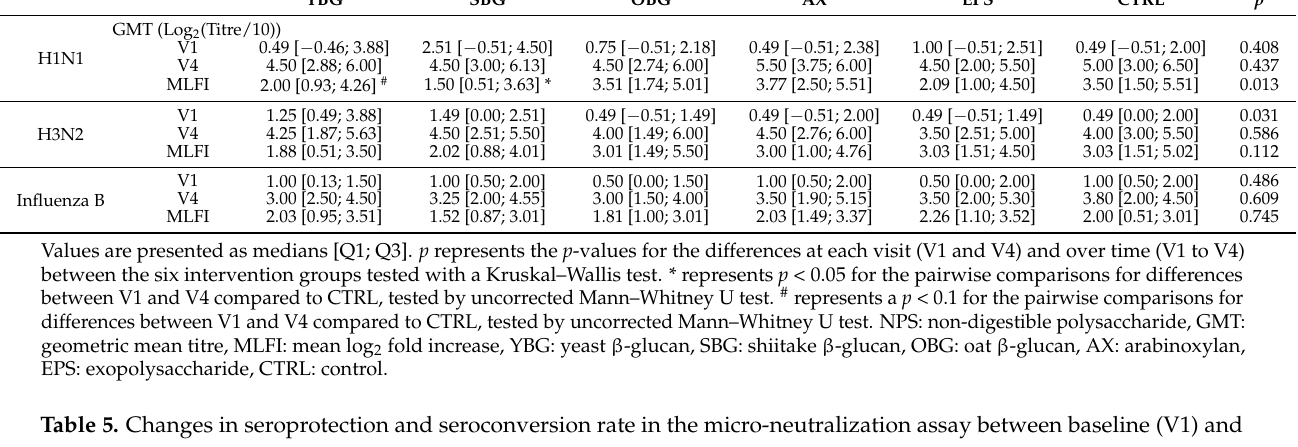
Table 5. Changes in seroprotection and seroconversion rate in the micro-neutralization assay between baseline (V1) and three weeks after vaccination (V4) in the different NPS intervention groups. YBG SBG OBG AX EPS CTRL p Seroprotection rate (%)